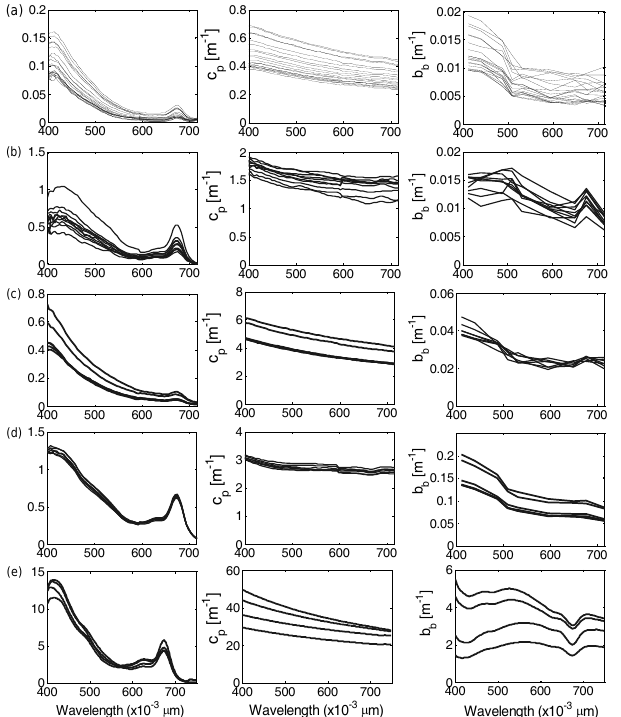
Figure 10. Spectral plots of the in situ IOPs (particulate absorption a p , particulate attenuation c p , and particulate backscattering b b ) from different waters. (a) Relatively clear waters off Chennai (St- 1), (b) moderately turbid waters off Point Calimere (St-5), (c) turbid waters off Point Calimere (St-4), (d) phytoplankton-dominated har- bour waters off Chennai (St-7) and (e) Eutrophic waters off Chennai (St-8–11).